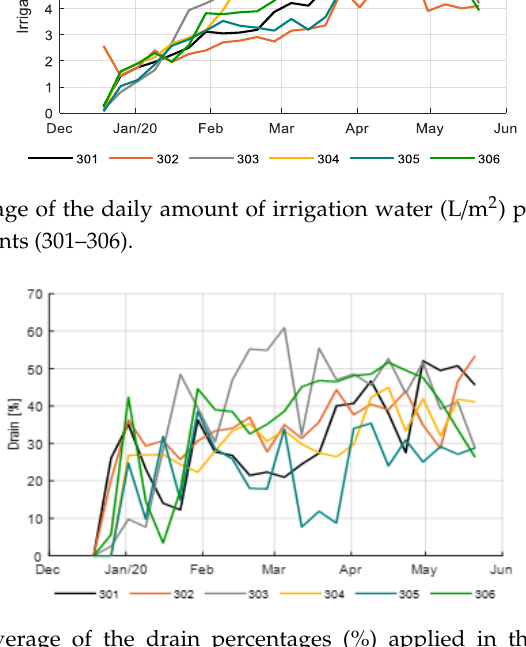
Figure 10. Weekly average of the drain percentages (%) applied in the different greenhouse compartments (301–306).